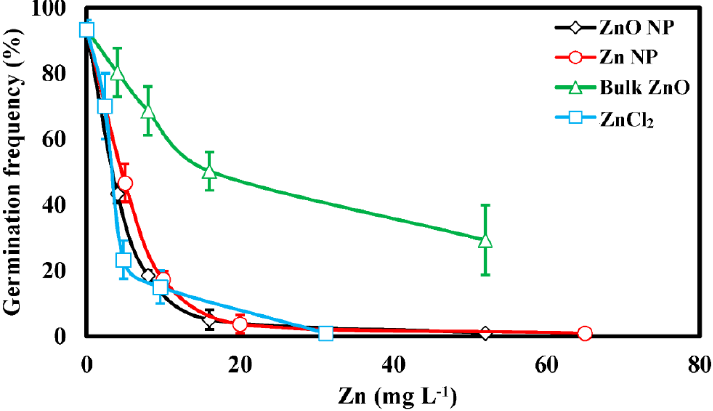
Figure 3. Germination frequency of Peronospora tabacina ( P. tabacina ) spores in the presence of Zn treatments. Error bars = standard deviation.